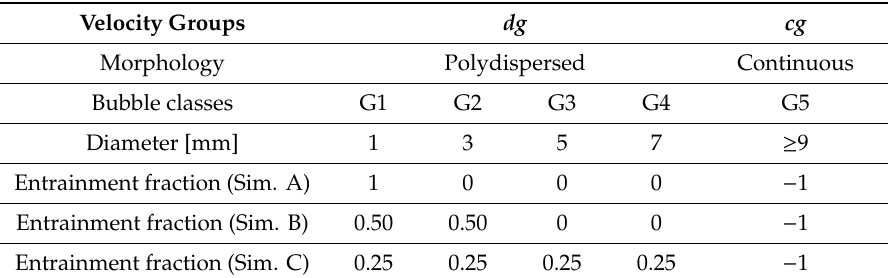
Figure 3. ( a ) Graphical representation of the computational domain and mesh; ( b ) CFD boundaries. Table 2. Setup for gas phase and entrainment fraction.